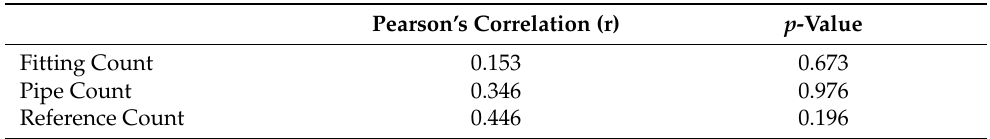
Table 8. Pearson’s correlation (r)—pipefitter interaction (average visit duration) by visual drawing complexity (number of fittings, pipes, and references).